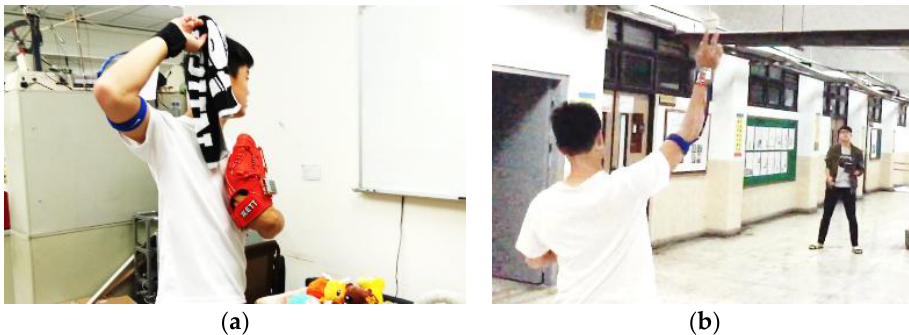
Figure 11. ( a ) Towel throwing method; ( b ) baseball throwing.